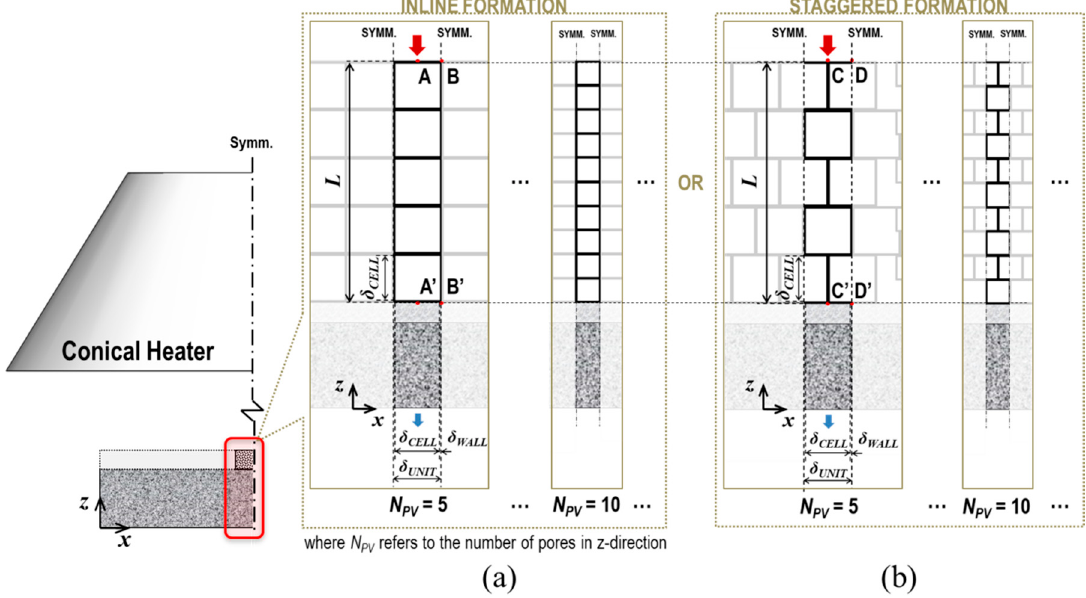
Figure 12. Scheme of FEA multicellular modelling: ( a ) inline and ( b ) staggered formations.